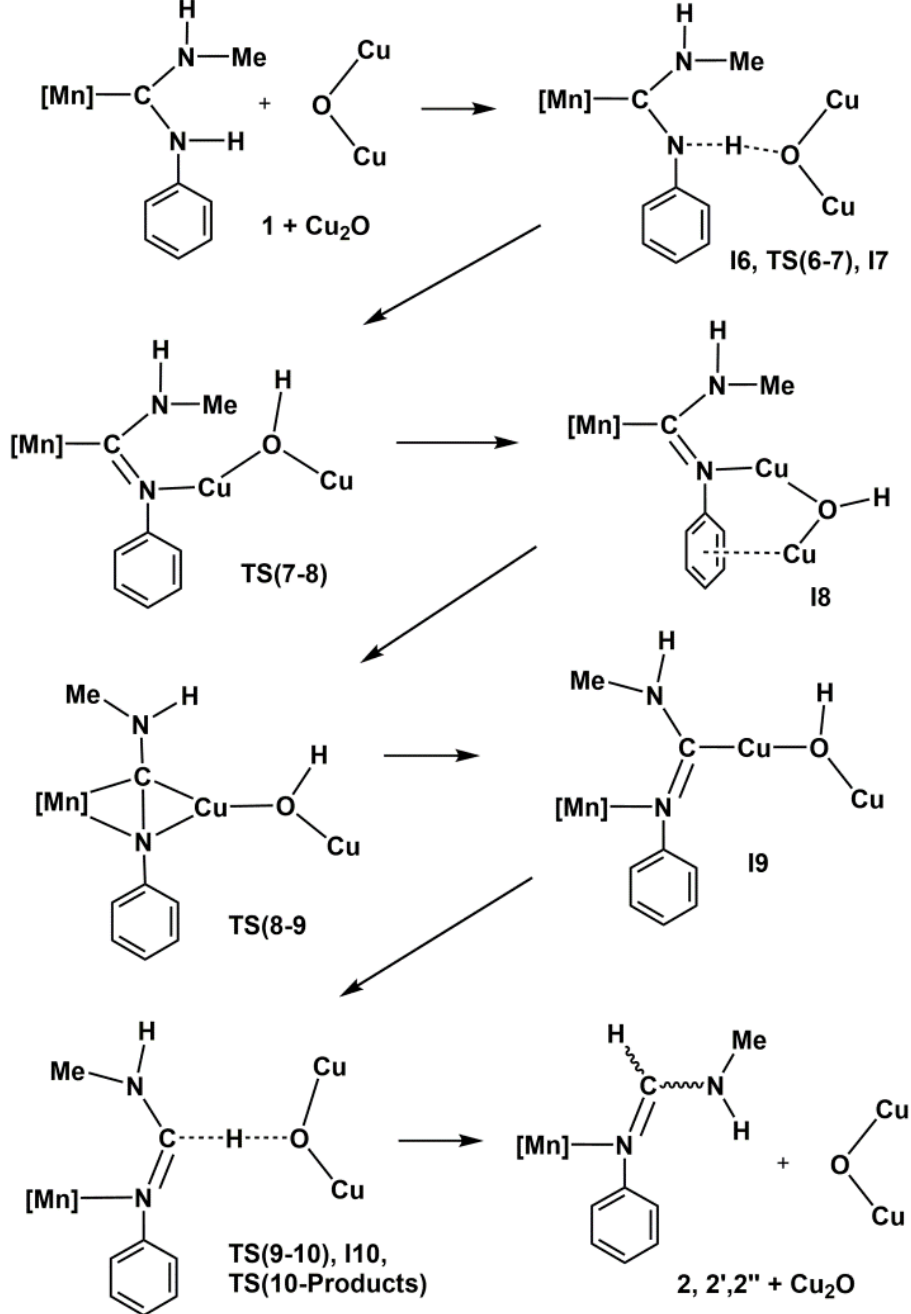
Scheme 3. Proposed mechanism for the isomerization of the diaminocarbene ligand in complex 1 to formamidine catalyzed by Cu 2 O. [Mn] = [Mn(CO) 3 (bipy)] +